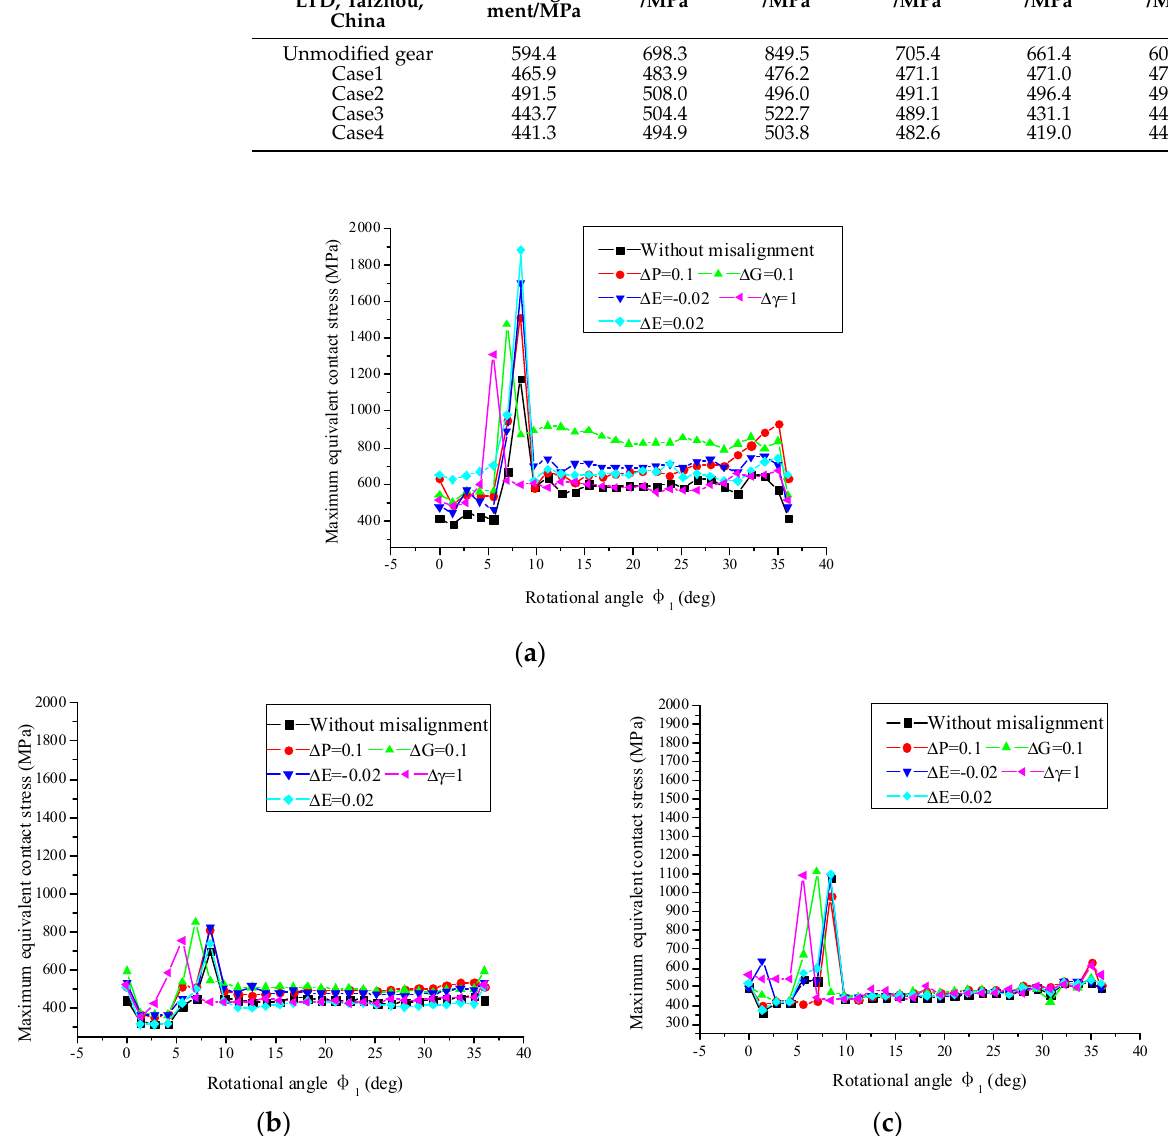
Figure 16. Variation of contact stress in a whole cycle for the ( a ) unmodified, ( b ) tooth end relief (Case4) and ( c ) symmetric crowned modification (Case1) driving opinion with alignment errors.